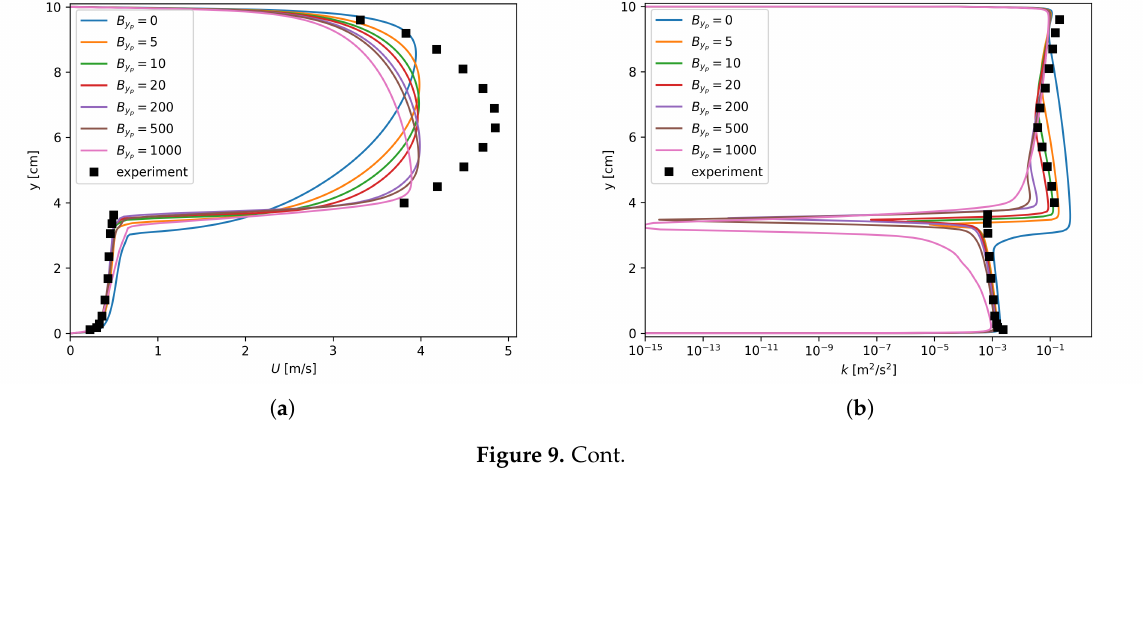
. ( a ) Run 250; ( b ) Run 400; ( c ) Run 600. p